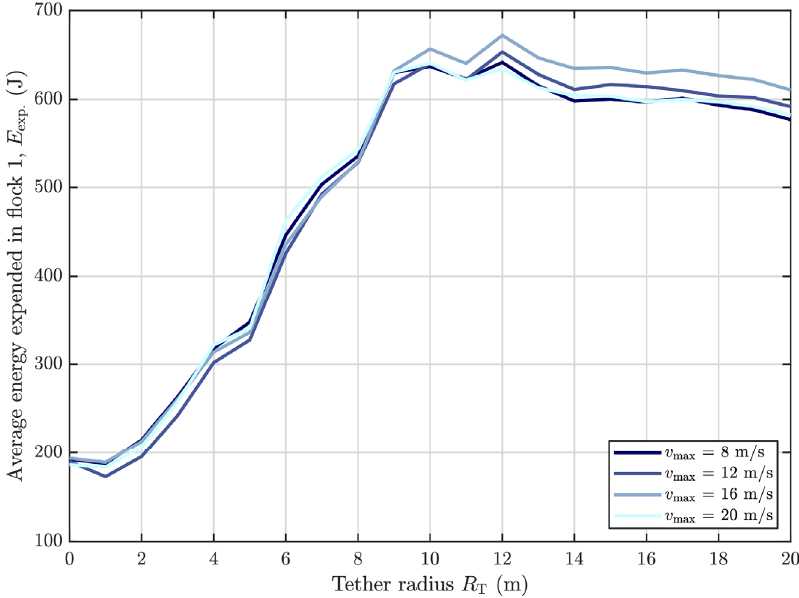
Figure 15. Impact of agent maximum speed on energy expenditure for a configuration of 𝑛 = 4 agents. Darker lines indicate maximum speed.